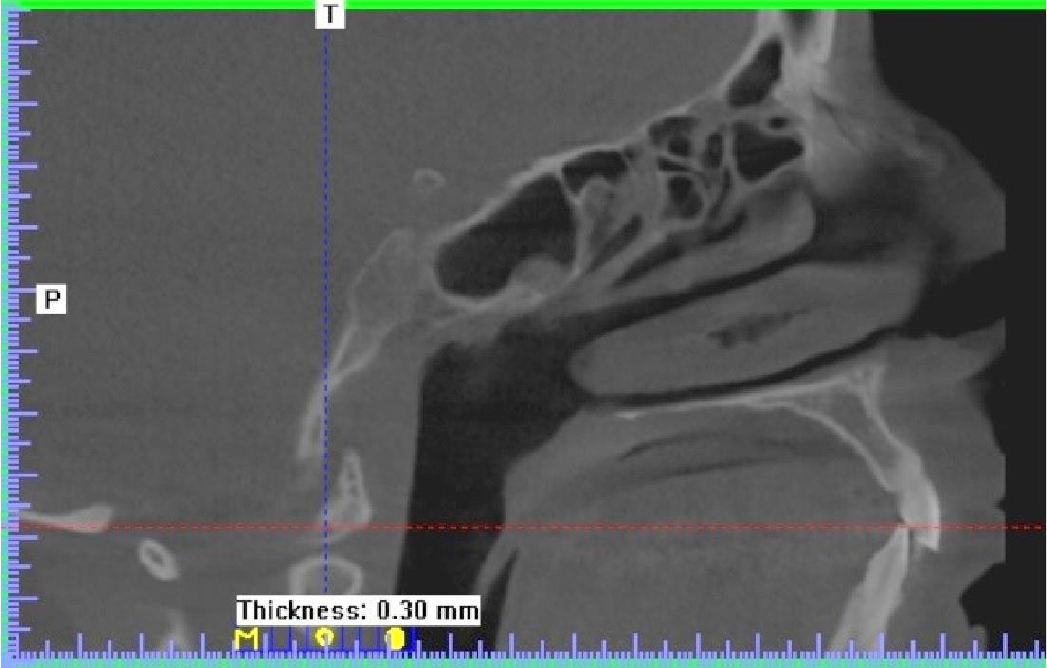
Figure 6. Ethmoid bulla and the sphenoid sinus—status after a series of 30 physical therapy sessions. (CBCT